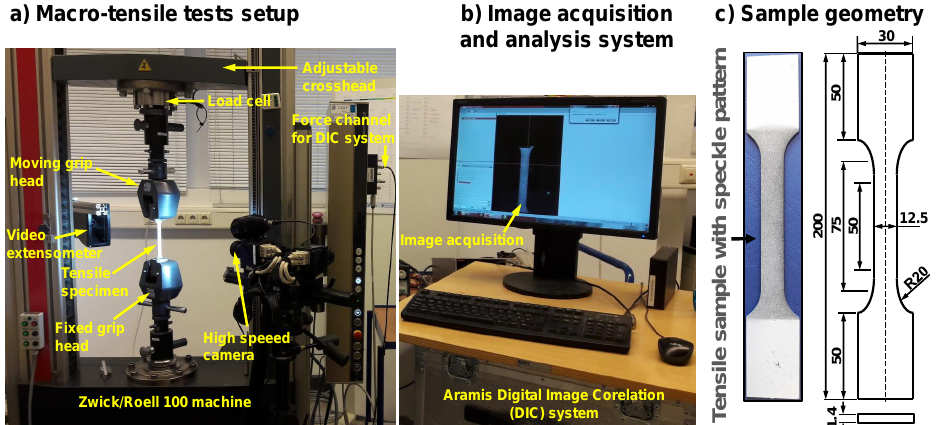
Figure A1. Macro-Tensile tests carried out in conjunction with DIC for investigating the local plastic strain ( ε local ) evolution, nucleation, and propagation of deformation bands with increasing strain. ( a ) Tensile testing machine depicting the adjustable crosshead, grips for clamping, load cell, video extensometer and high-speed camera for image acquisition, ( b ) Aramis DIC system used for analysis, ( c ) Tensile sample with black and white speckle pattern prepared for ε local measurement.